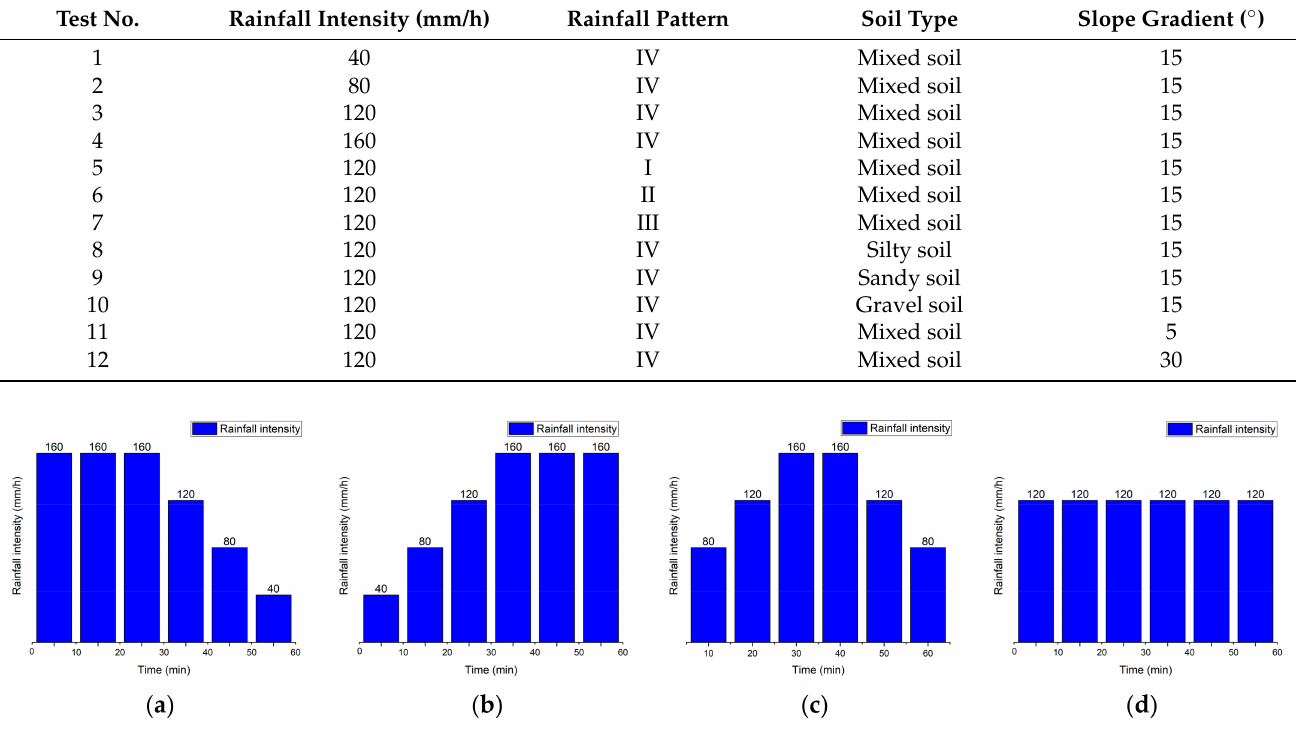
Figure 3. Rainfall patterns: ( a ) Pattern I; ( b ) Pattern II; ( c ) Pattern III; ( d ) Pattern IV.